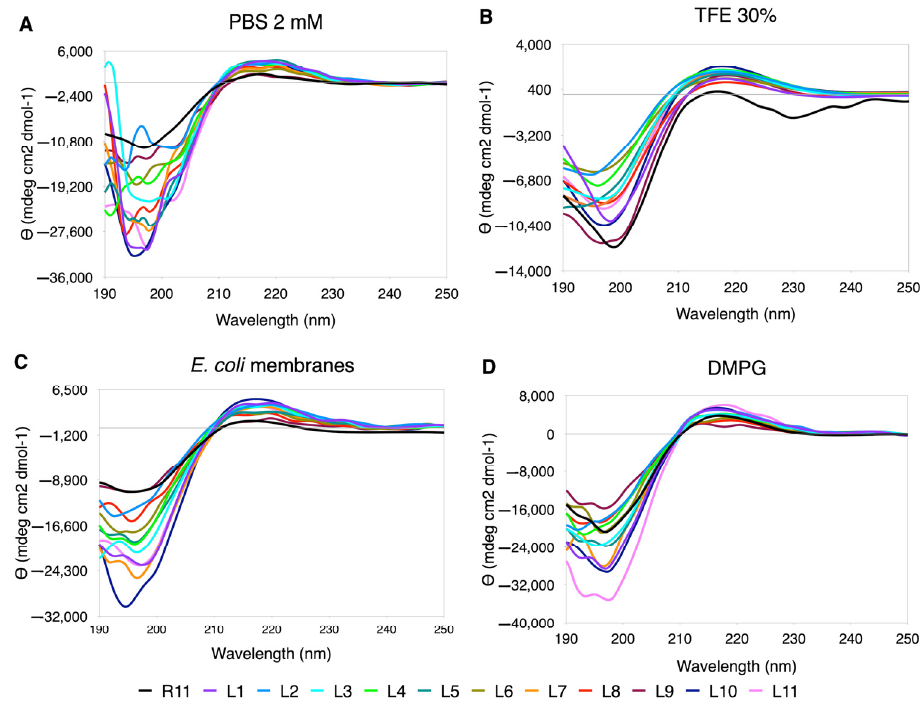
Figure 5. CD spectra for Leu scanning of R11 in the four media used. ( A ) TFE 30%. ( B ) PBS 2 mM. ( C ) DMPG. ( D ) E. coli membranes extract.